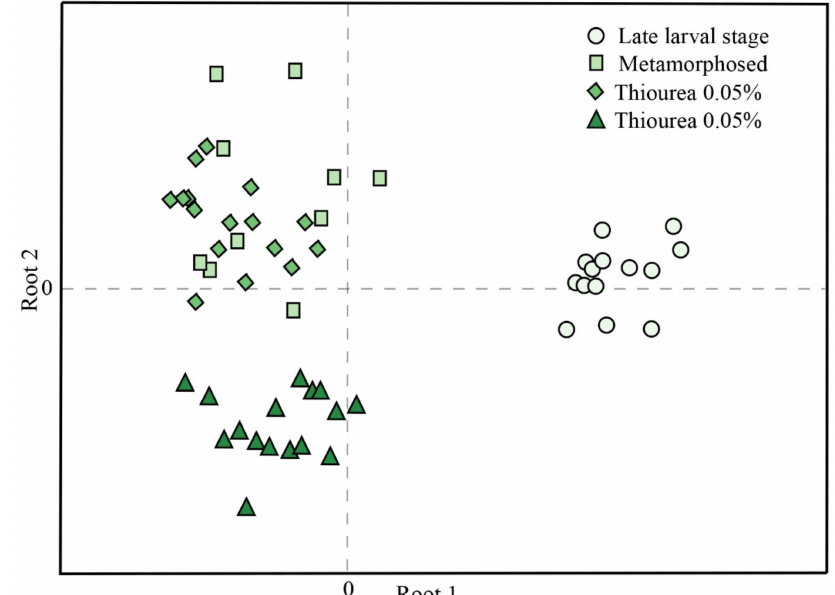
Figure 2. Canonical discriminant analysis of oxidative stress parameters (SOD, CAT, GSH-Px, GR, GST, GSH, TBARS, and SH groups) in crested newts ( Triturus spp.) in late larval stage (62 stage) (n = 14), newly metamorphosed (n = 10), and metamorphosis-arrested (exposed to low (0.05%) (n = 16) and high (0.1%) (n = 16) thiourea concentrations) individuals. Groups were formed by Root 1 (the first canonical function) and Root 2 (the second canonical function). n—number of individuals per